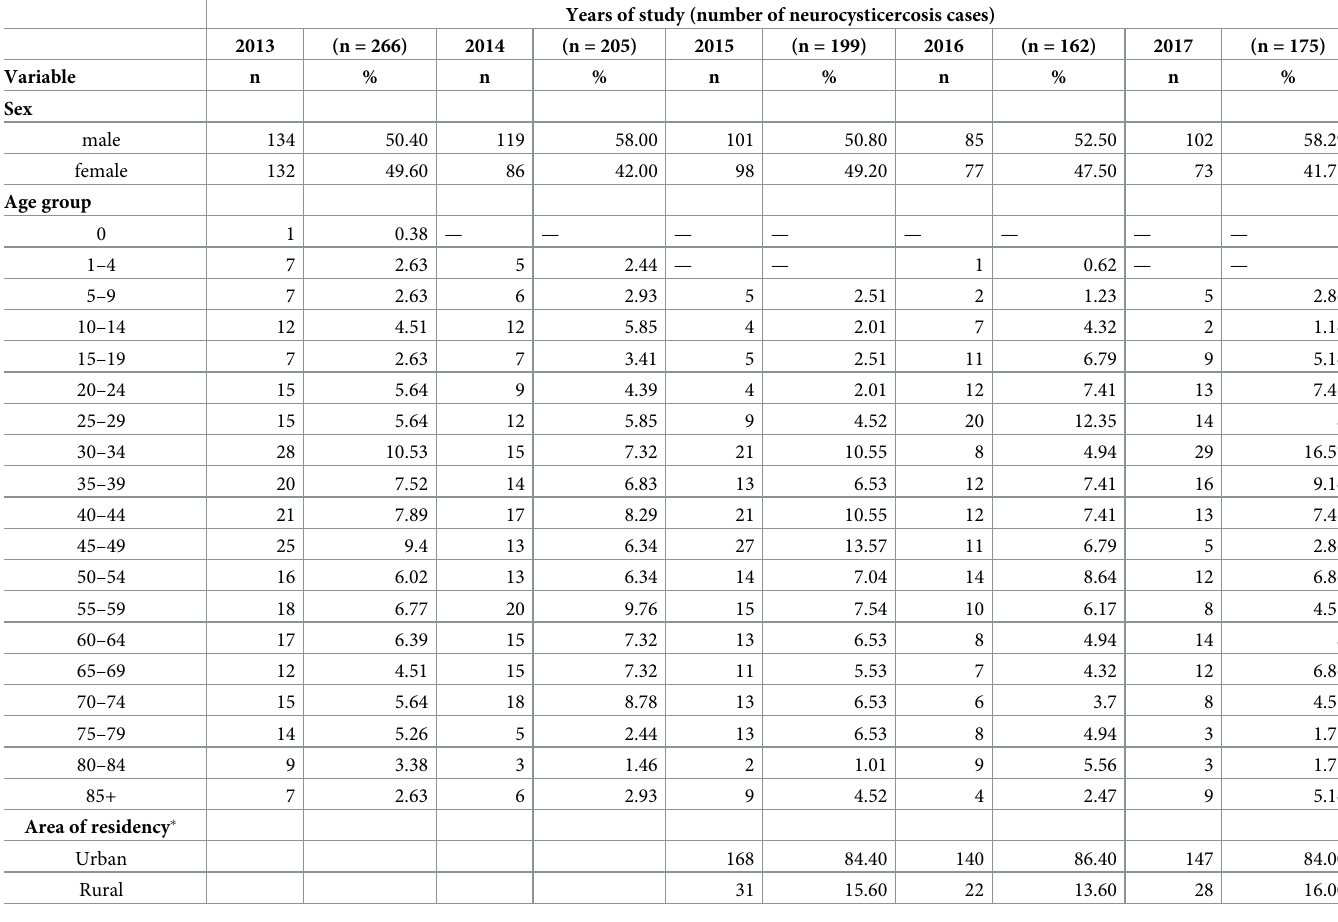
Table 2. Distribution by sex, age group and area of residency of hospitalizations due to neurocysticercosis in Ecuador,